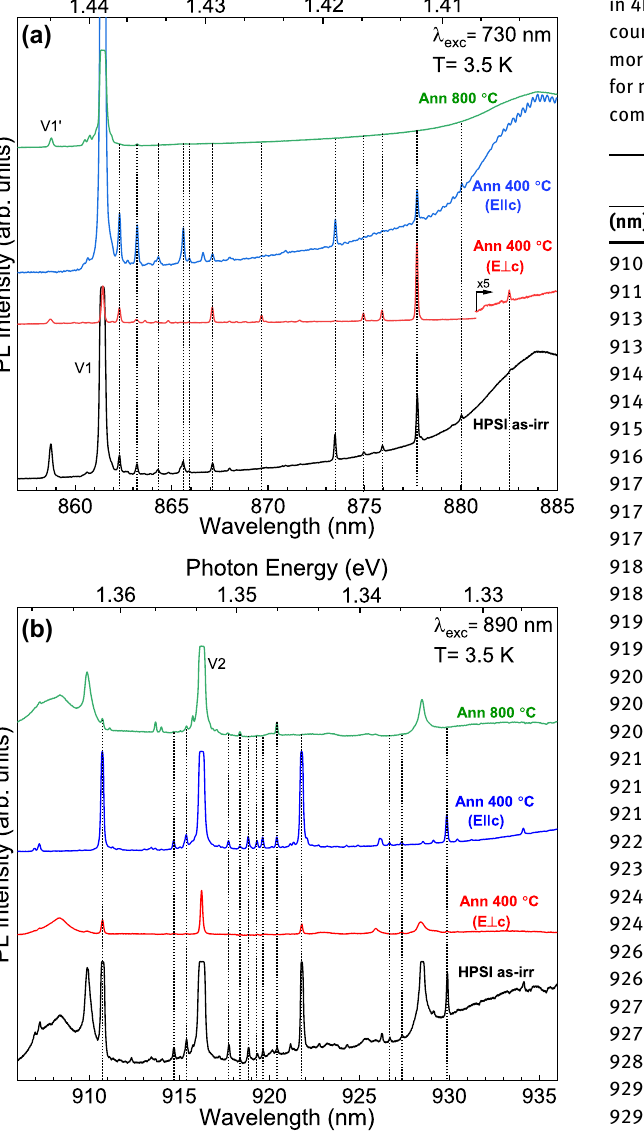
Figure 6: PL for the high-purity semi-insulating 4H-SiC samples. (a) Show the range of 860–885 nm containing the V1 and V1 ′ signals and (b) show the range of 910–935 nm containing the V2 signal. The figures show there are several small additional lines next to the V1 and V2 lines. These additional lines appear in as-irradiated samples and only some faint signals remain after annealing at 800 ◦ C. The polarization is also shown for the 400 ◦ C annealed sample.